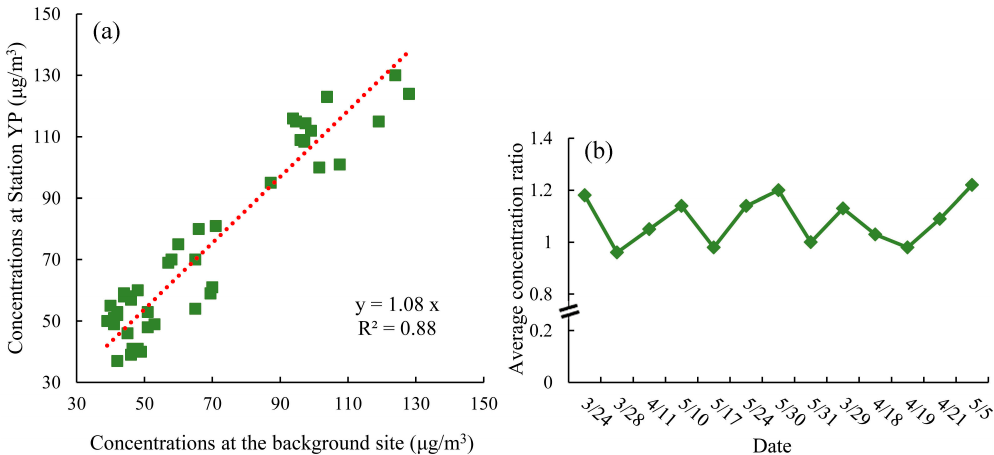
Figure 2. Comparison of PM 10 concentrations at the background site and Station YP ( μ g/m 3 ). ( a ) Concentrations at the background site and Station YP; ( b ) Average concentration ratios on individual days.